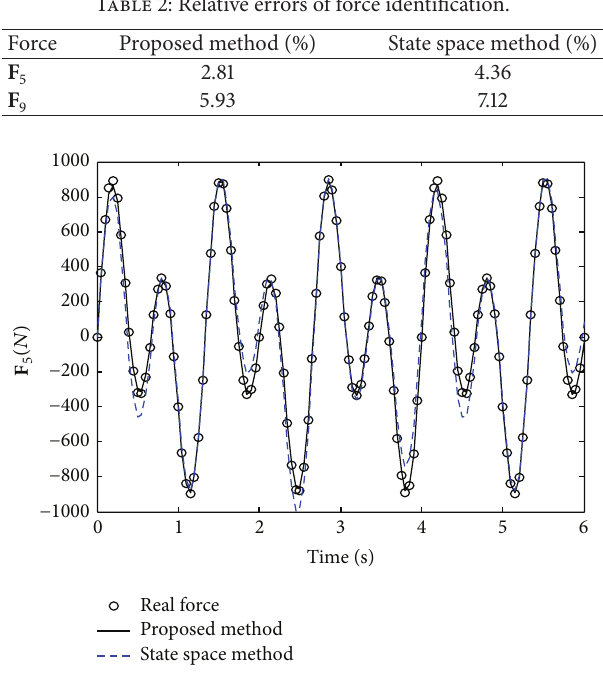
Figure 4: Force identification results of F 5 .